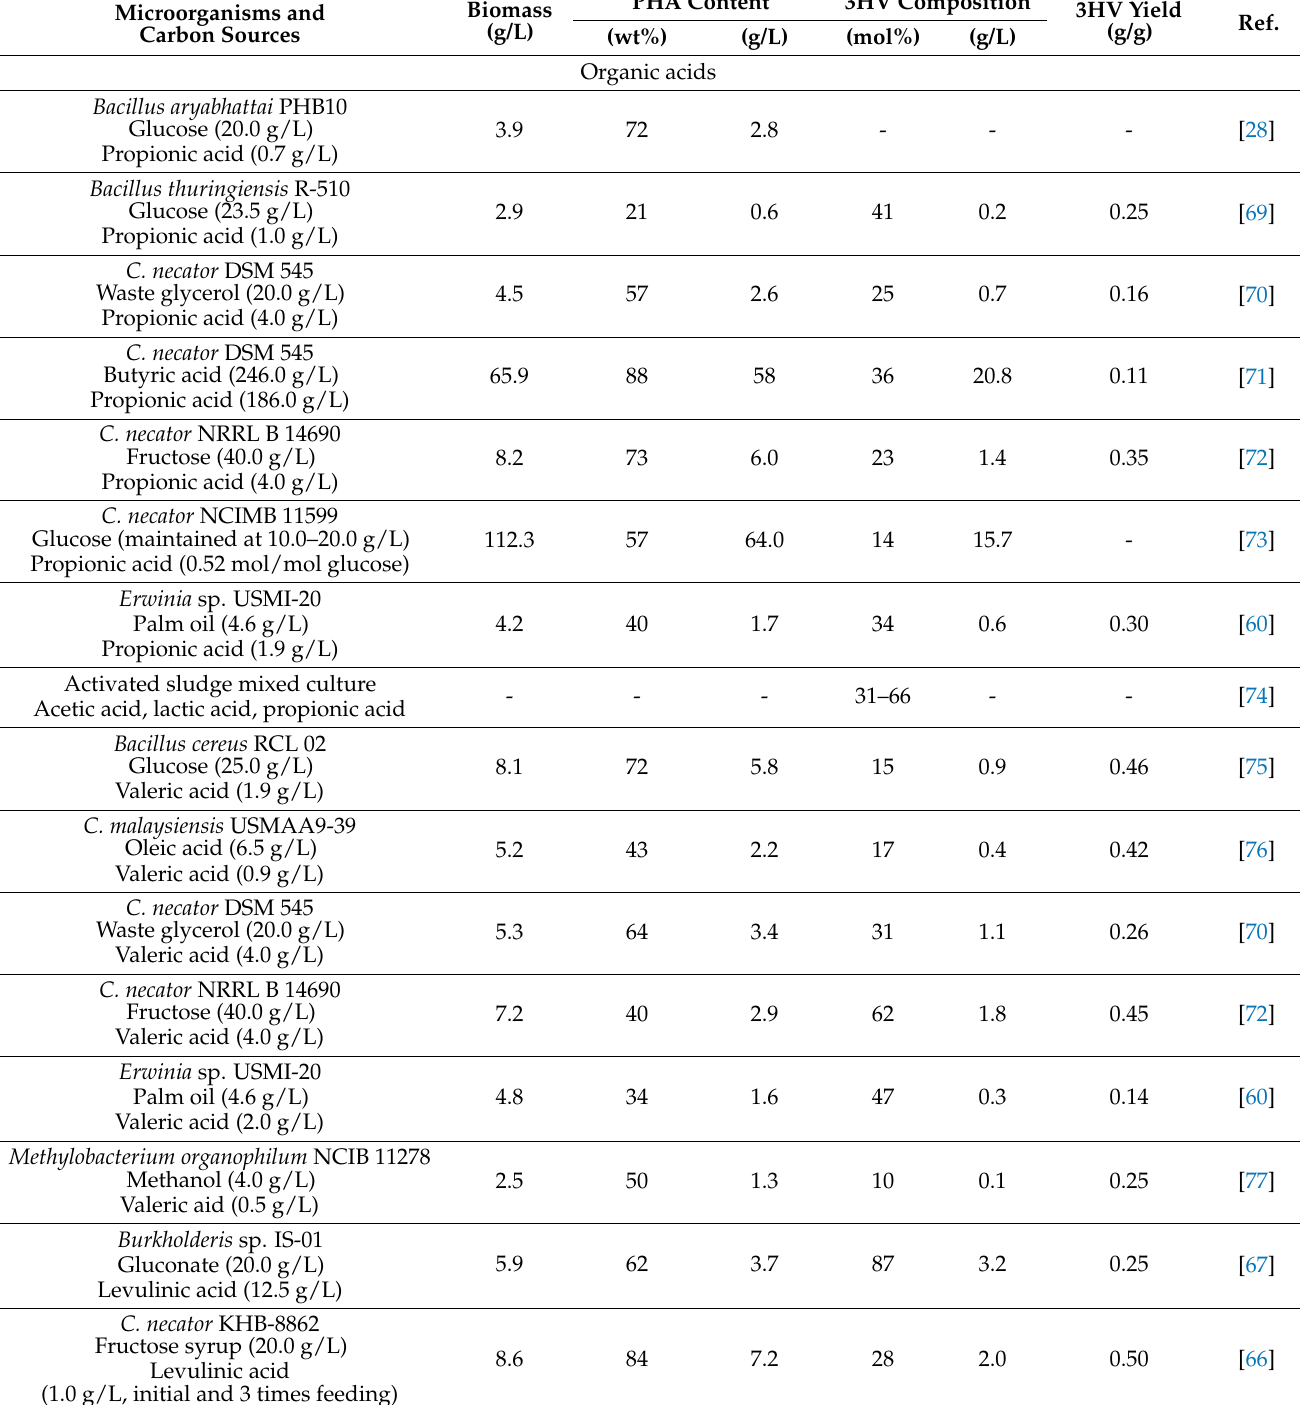
Table 2. P(3HB-co-3HV) production by bacteria from various 3HV